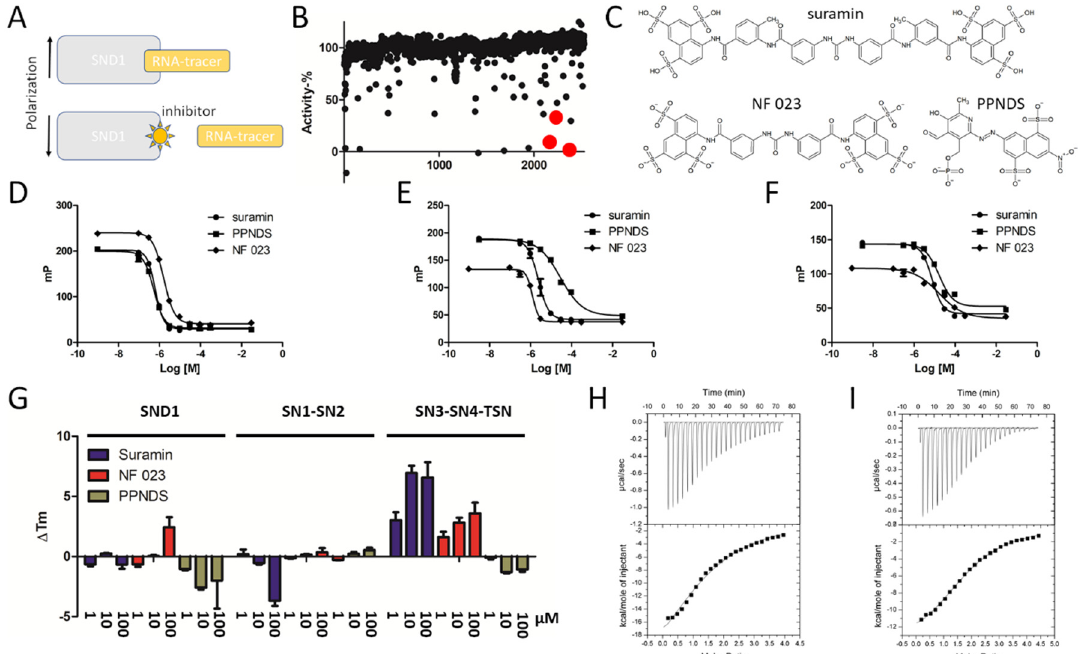
Figure 4. Inhibitor screening and validation. ( A ) Principle of the FP-based screening assay. Binding of an inhibitor displaces RNA-tracer and decreases polarized fluorescence emission. ( B ) Inhibitor screening. LOPAC 1280 library and handpicked nucleotide analogs were screened with the FP assay. Suramin, NF 023, and PPNDS are marked as red spheres. ( C ) Chemical structures of three hit